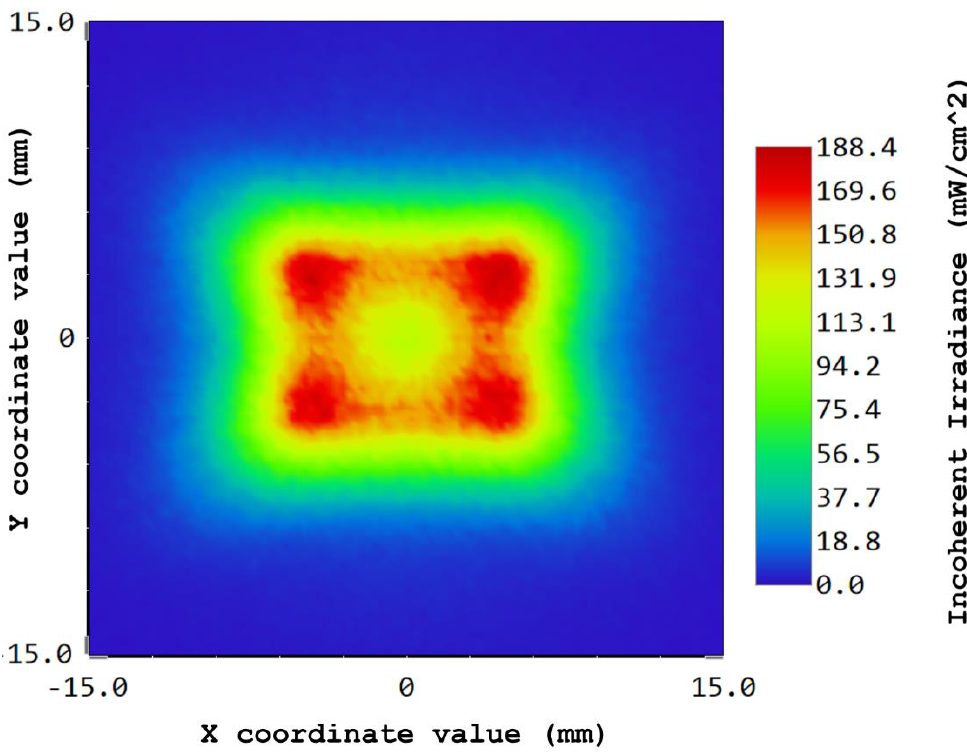
Figure 8. Incoherent irradiance of the vertical-cavity surface-emitting laser (VCSEL) array on a square detector at 1 cm.